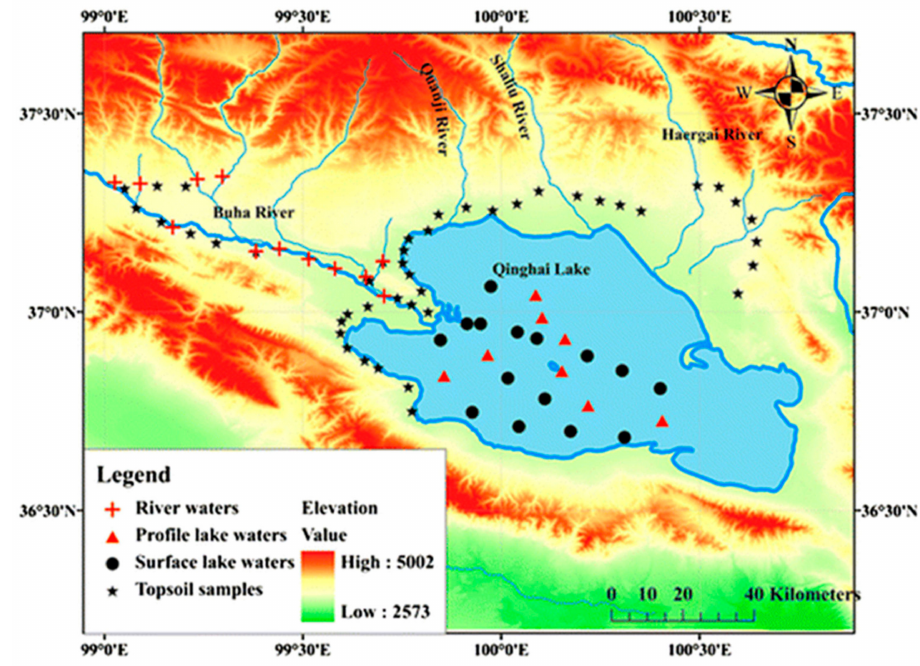
Figure 1. Locations of sampling sites in/around Lake